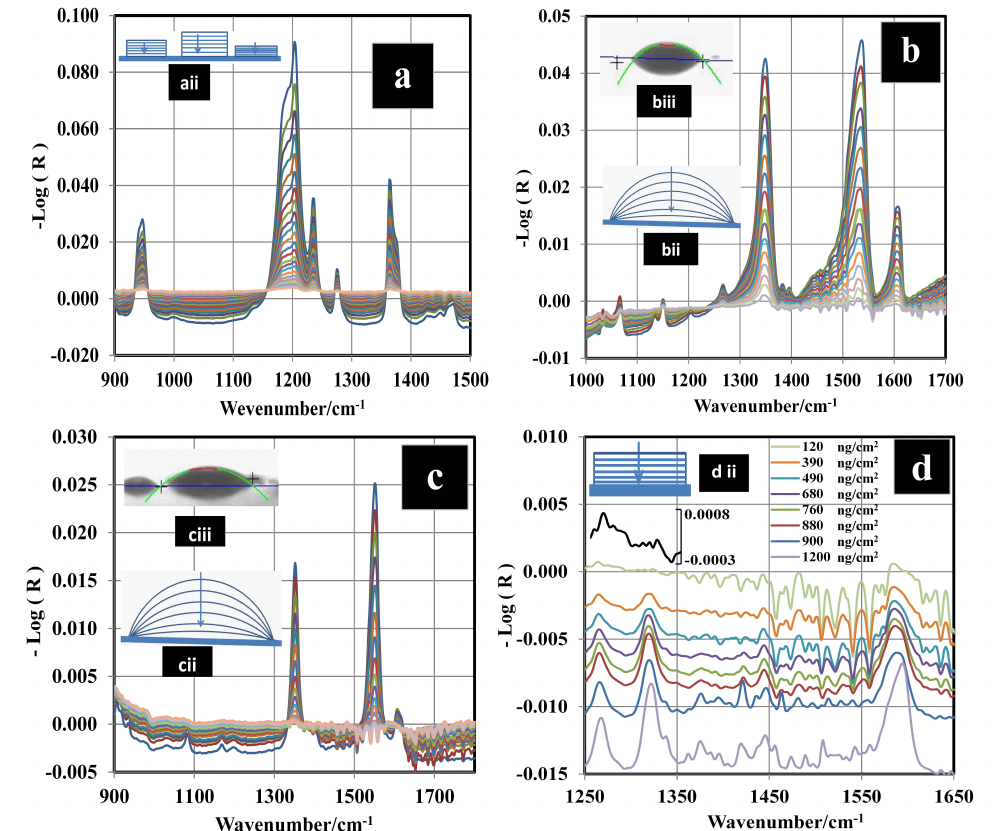
Figure 2. Mid-infrared (MIR) reflectance spectra for different HEMs undergoing sublimation on stainless steel (SS) surfaces. ( a ) TATP at 24 ◦ C, ( b ) 2,4-DNT at 35 ◦ C, ( c ) TNT at 70 ◦ C, and ( d ) RDX at 80 ◦